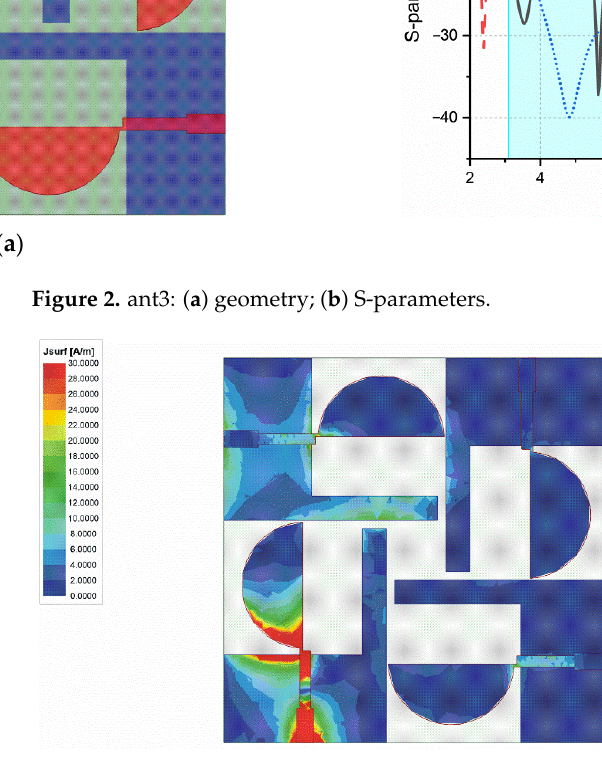
Figure 3. Surface current distribution at 6.5 GHz for ant3.